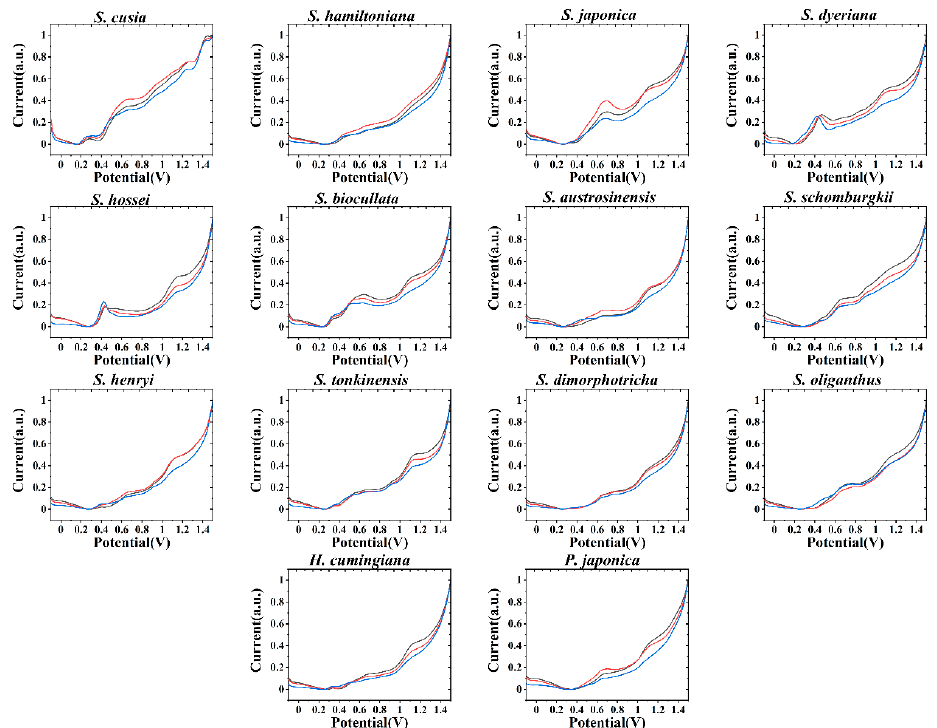
Figure 2. Electrochemical fingerprint of S. hossei, S. japonica, S. dimorphotricha, S. cusia, S. biocullata, S. oliganthus, S. hamil- toniana, S. austrosinensis, S. henryi, S. tonkinensis, S. schomburgkii, S. dyeriana, S. hamiltoniana, H. cumingiana and P. japonica recorded after ethanol extraction in